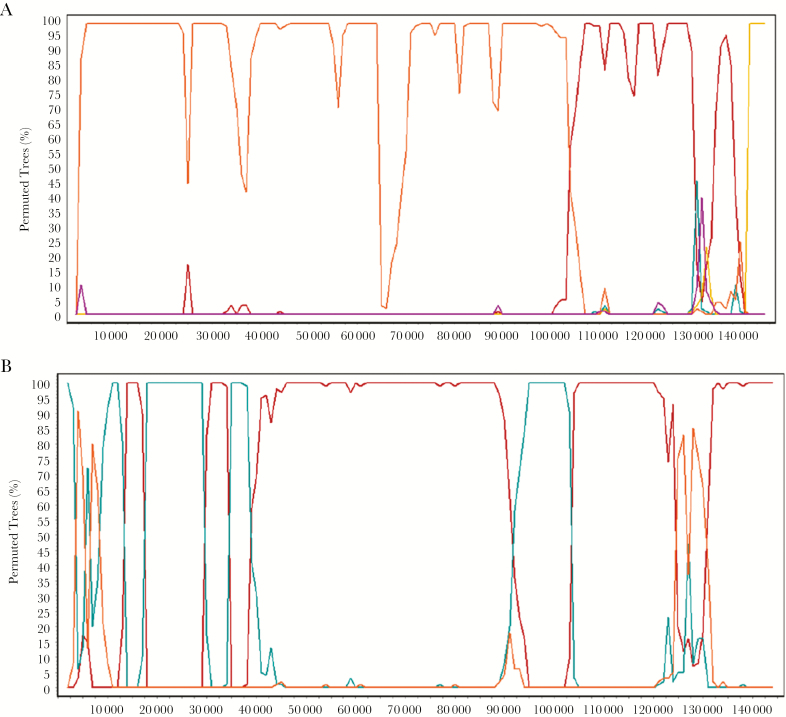
Evidence for recombination between different Kaposi sarcoma-associated herpesvirus types. A, Intertypic recombinant type M2. Bootscan plot comparing type M2 query with consensus sequence of types P2 (red), P1(green), M1(yellow), N (purple), and ZM004 (orange). B, Intratypic recombinant ZM091. Bootscan plot comparing ZM091 with consensus sequences of types P2 (red), P1(green), and ZM004 (orange). Shifting phylogenetic signals and fragmented genomes are indicative of the presence of recombination.